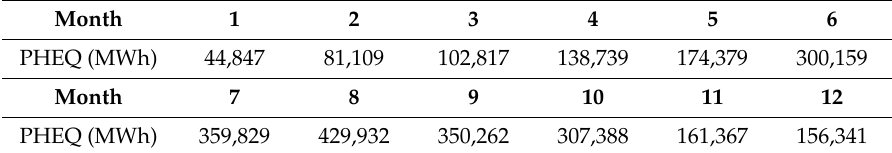
Table 7. The monthly predicted hydropower electrical energy.